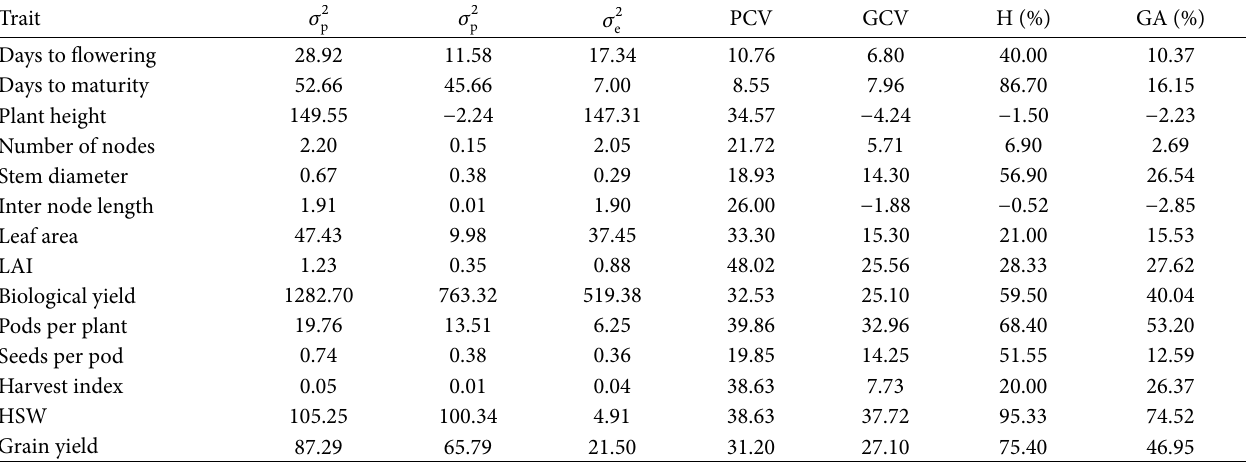
Table 3: Phenotypic and genotypic coefficient of variability, heritability and genetic advance for genotypes.